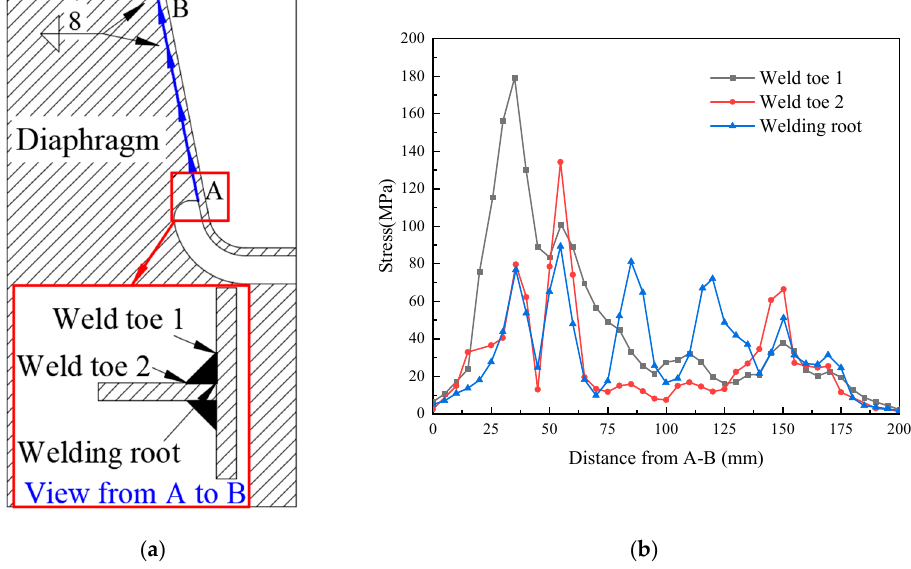
Figure 11. Area of concern and welded seam stress. ( a ) Schematic diagram of welded seams; ( b ) seam stress.